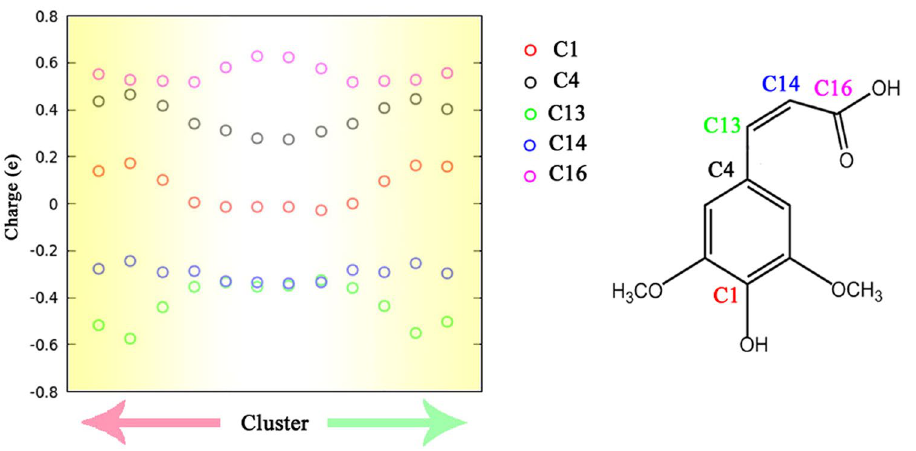
Figure 5. The average partial charges of each meta-stable pattern for a few selected atoms of SA molecule. The value of the meta-stable patterns 1/1 ′ are shown in the middle of the X